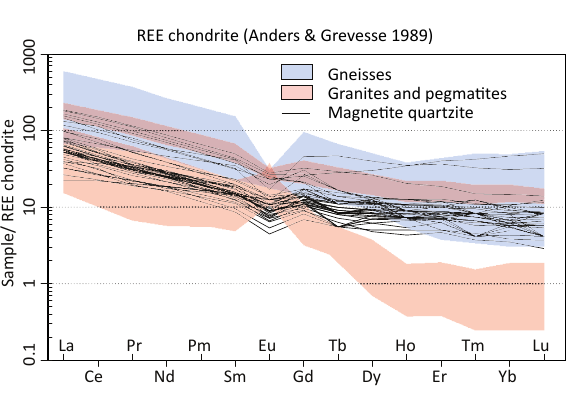
Fig. 7. Chondrite­normalized REE elements in the Jõhvi Zone rock types. Note the overlapping of magnetite quartzites and sur­ rounding gneisses and possibly two geochemical groups for cut­ ting granitoid rocks. Selected geochemical analyses in Table 2; full set of analyses at